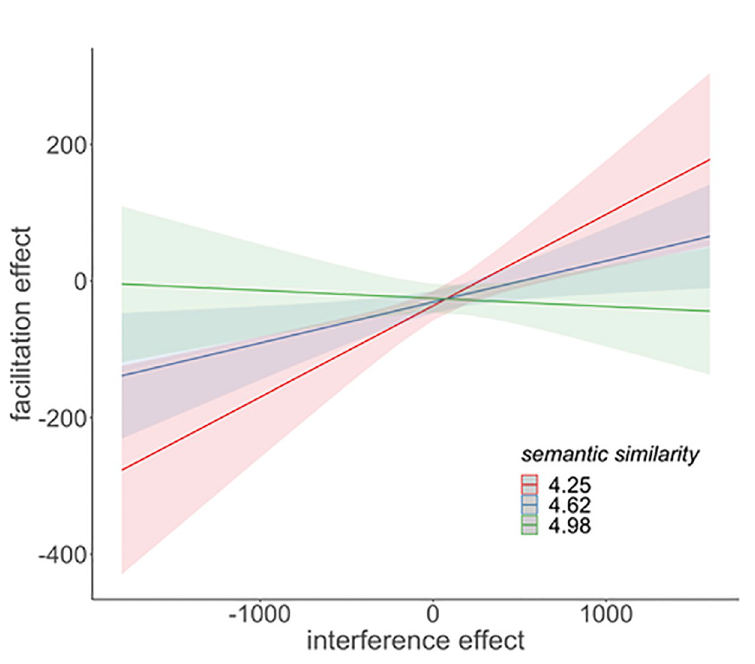
Fig 6. Depiction of the interaction of Interference effect and Semantic similarity found in the analysis for simple nouns. A strong interference effect (x-axis, in ms) predicts a weak facilitation effect (y-axis) but only for items that are less-closely related.